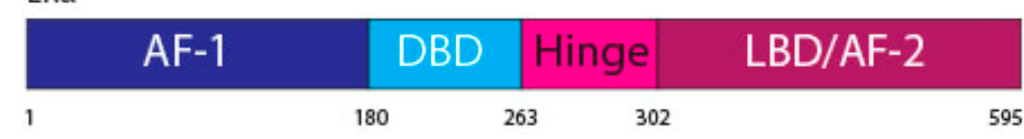
Figure 1. ER α functional domains. The ER α functional domains include; Activation Function 1 (AF-1) (purple), DNA Binding Domain (DBD) (blue), hinge (pink), Ligand Binding Domain (LBD) and AF-2 (plum). Upon estrogen binding, ER forms homodimers (ER α / ER α or ER β / ER β ) and heterodimers